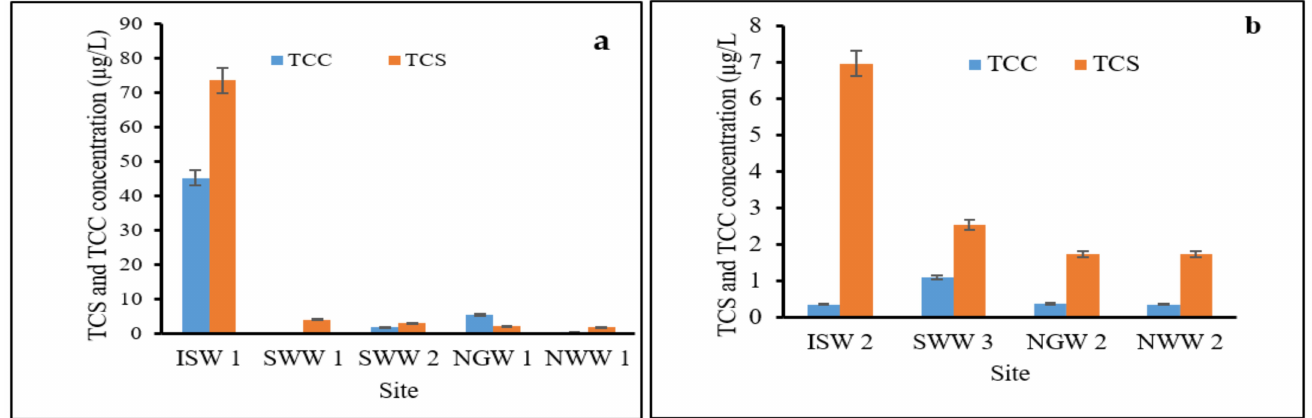
Figure 3. Concentrations of TCS and TCC in wastewater influent and effluent samples. ( a ) con- centrations of TCS and TCC in the influent samples; ( b ) concentrations of TCS and TCC in the effluent